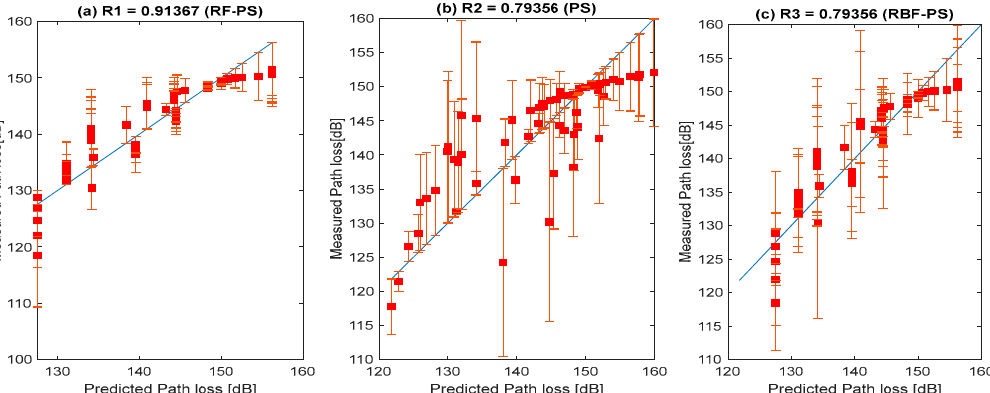
Figure 30. Results showing the correlation between the measured path loss and predicted path loss using the hybrid RF-PS prediction method and two existing standard path loss prediction methods in site 2 of location 4.